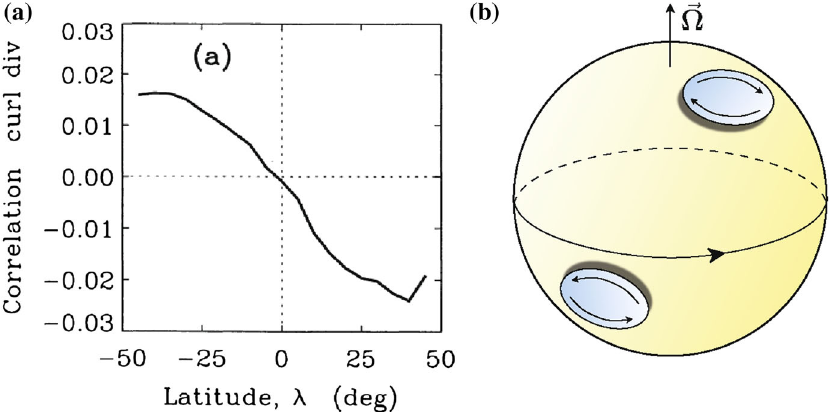
Fig. 5 a Correlation between the horizontal divergence and vertical vorticity of the supergranulation flow as a function of latitude. Image reproduced with permission from Gizon and Duvall (2003), copyright by ESA. b Schematic view of anticyclones at the surface of the rotating Sun